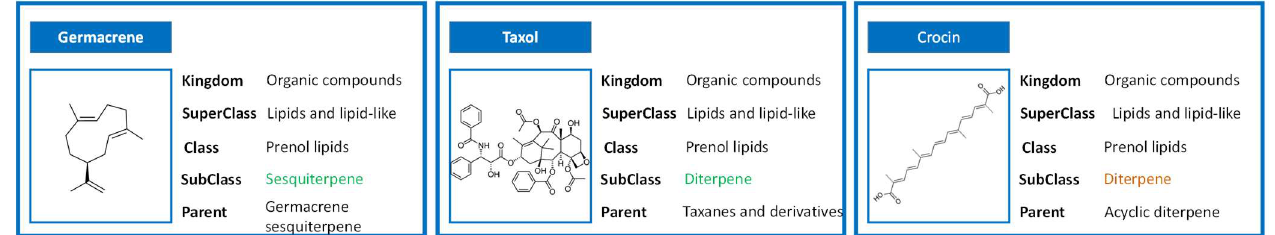
Figure 2. Chemical classification of germacrene, taxol and crocin according to Figure 2 - Chemical classification of germacrene, taxol and crocin according to ClassyFire.